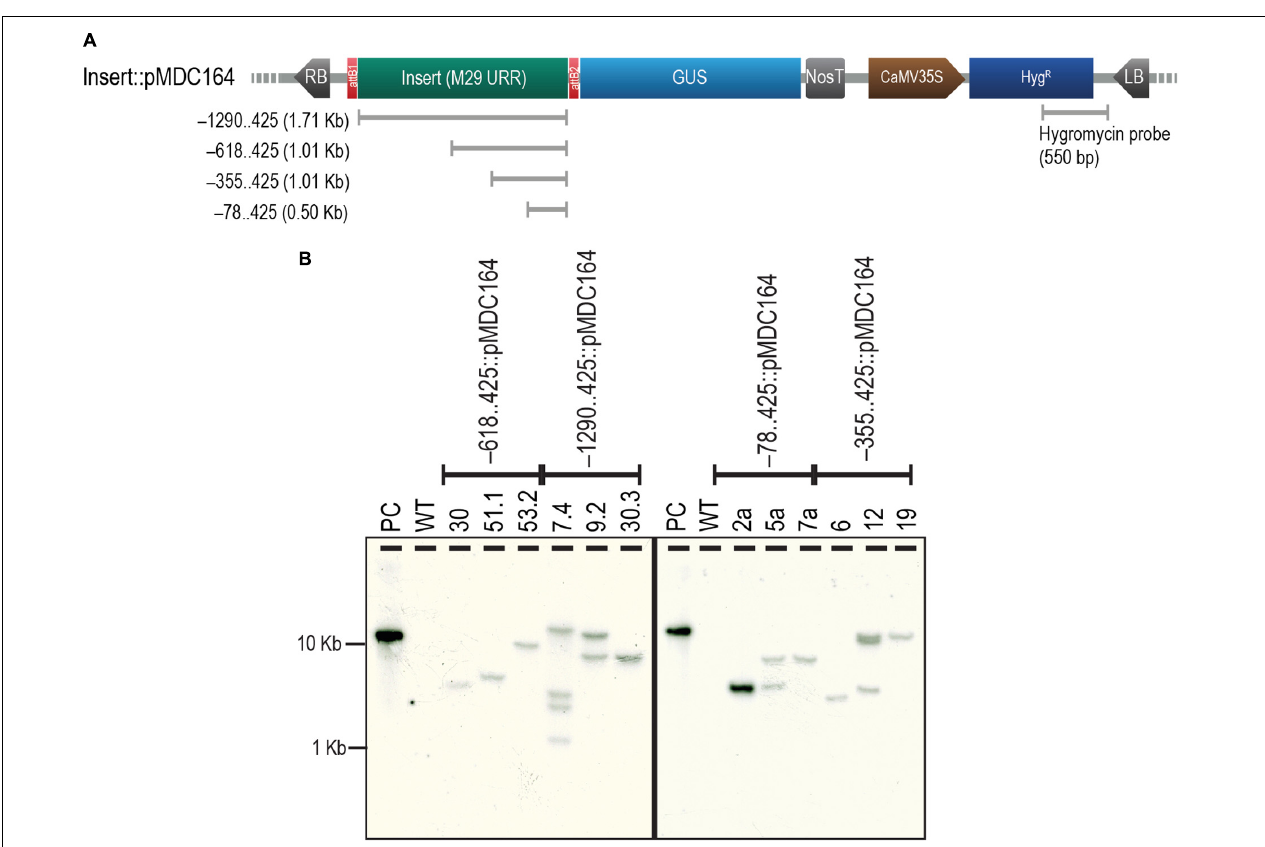
FIGURE 2 | Analysis of T-DNA copy number of transgenics by Southern hybridization. (A) Map of pMDC164 showing the T-DNA region harboring the URR deletion inserts fused to a downstream GUS reporter and the CaMV 35S promoter-driven hygromycin antibiotic-selection gene. The region of hygromycin and the vector backbone used as a probe for the Southern hybridization experiments has been indicated. (B) Results of the Southern hybridization experiment show the copy number in each of the transgenics. Positive control (PC) is a Hin dIII linearized –78..425:pMDC164 plasmid and an untransformed wild-type (WT) was used as a negative control for this experiment. The blot was photographed using an HP Scanjet G4050